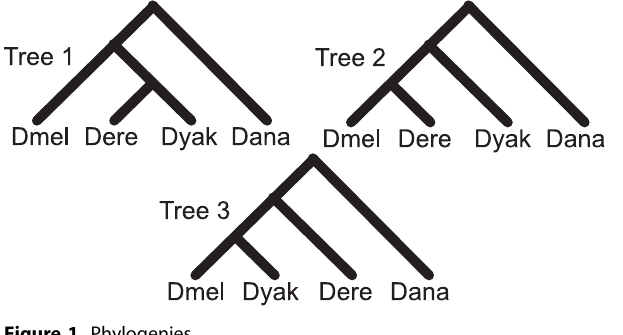
Figure 1. Phylogenies The three possible phylogenies for Dmel, Dere , and Dyak, with Dana as an